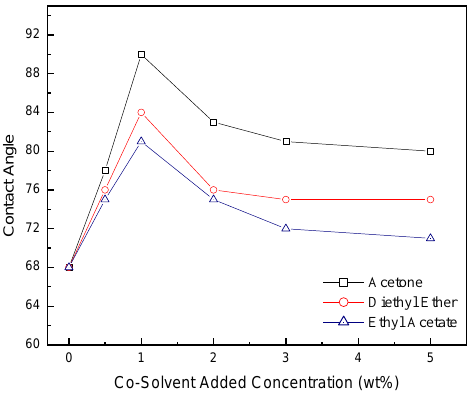
Figure 6. Contact angle as a function of co-solvent concentrations.